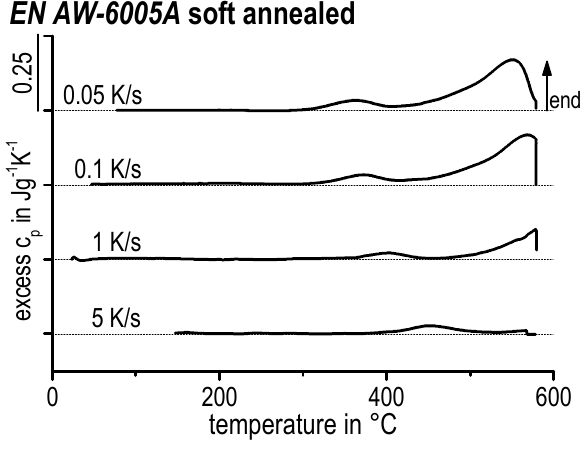
Figure 9. Selected heating curves of EN AW-6005A for the SA initial